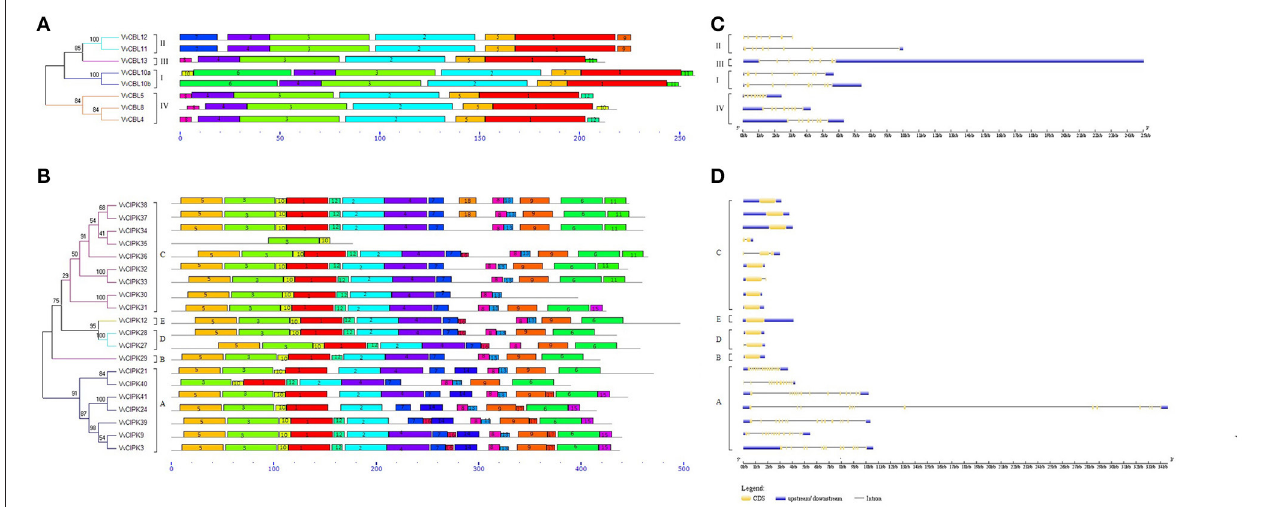
FIGURE 2 | Conserved motifs of grapevine CBL (A) and CIPK (B) proteins and gene structures of grapevine CBL (C) and CIPK (D) genes. The conserved motifs of VvCBL and VvCIPK proteins were performed using MEME program and arranged corresponding to the phylogenetic tree. Different motifs are highlighted with different color boxes and numbers. The length of boxes corresponded to motif length. The gene structures were drawn using the GSDS program. The yellow boxes represent exons, the lines represent introns and the blue boxes represent upstream/downstream UTRs. Subgroup B, C, D, and E of grapevine CIPK family constituted an obviously intron poor clade.